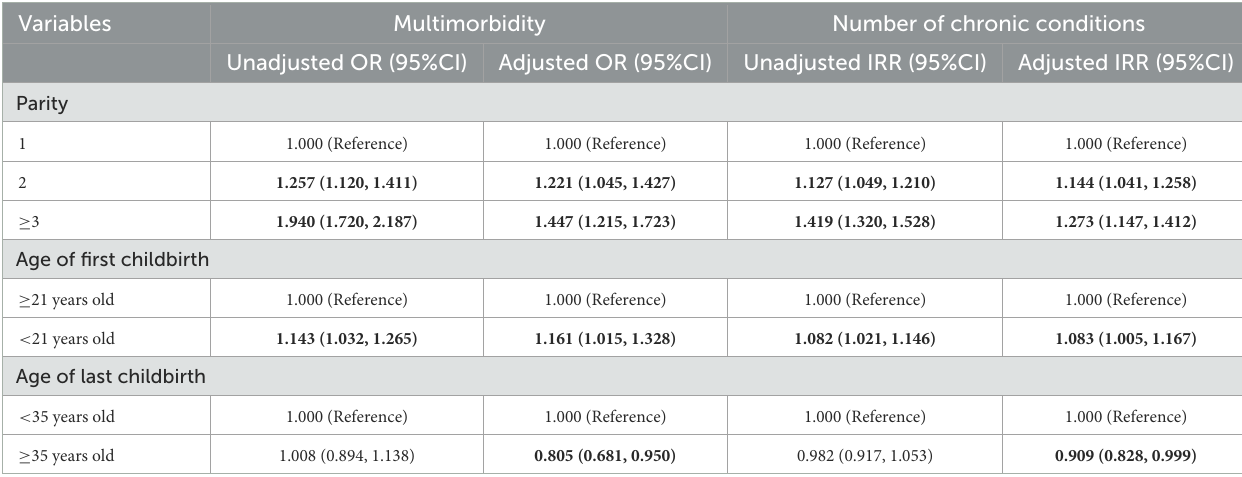
TABLE 2 Association of female fertility history with multimorbidity and the number of chronic conditions. Variables